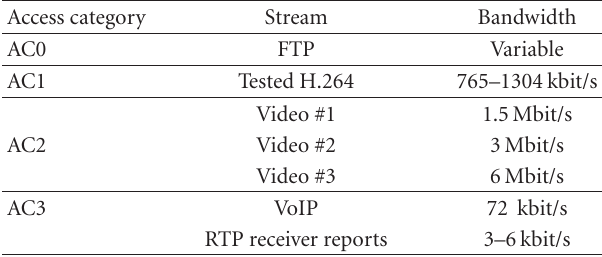
Table 2: Access category assignment for all tra ffi